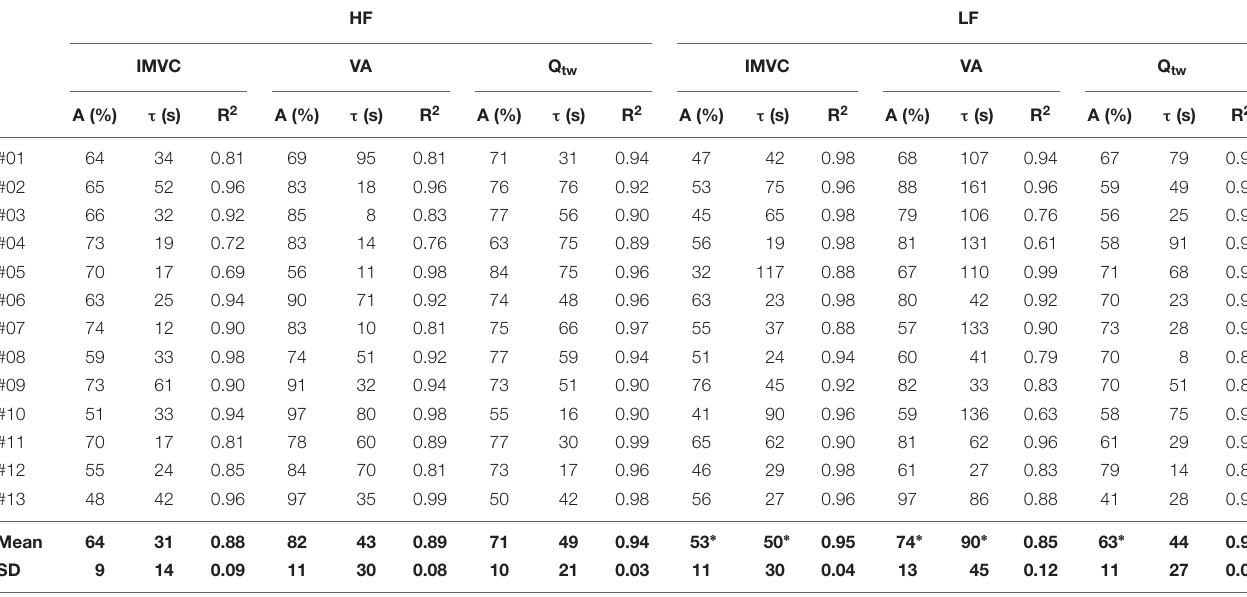
TABLE 1 | Individual exponential models of fatigue for high force (HF) and low force (LF) conditions.